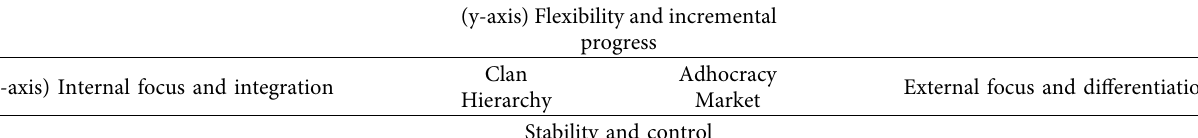
Table 1: Summary of the competing value framework of organizational